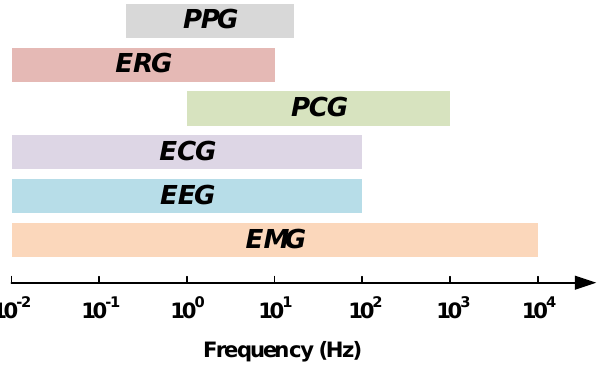
Figure 3. Bandwidths of some vital physiological signals (modified from